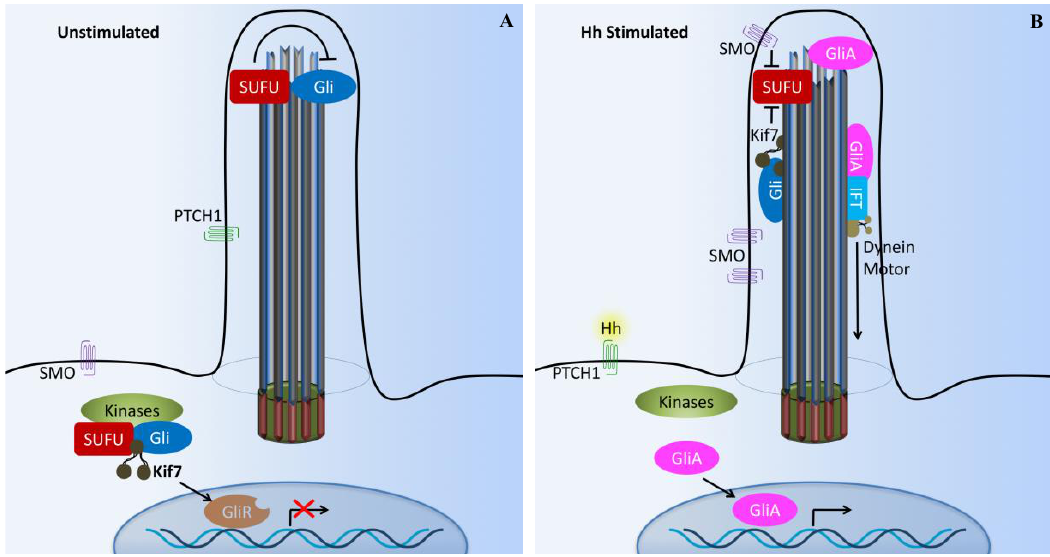
Figure 3. Cilia-dependent Hedgehog signaling. ( A ) The Hedgehog (Hh) pathway in vertebrates utilizes cilium as a signal transduction compartment. In the absence of the Hh ligand, the PTCH1 receptor localizes to the cilium and is thought to block the entry of SMO into cilia. The kinesin Kif7 (the COS2 homologue) localizes to the base of the cilium, where it may form a complex with Gli transcription factors and other pathway components. Kif7 at the cilium base prevents Gli proteins’ enrichment within the cilium and promotes processing of GliRs. ( B ) Upon Hh binding, SMO moves to the ciliary membrane and Kif7 translocates into the primary cilium, thereby promoting Gli accumulation at the ciliary tip. Kif7 and SMP in the cilia may also block the function of SUFU. Activated Gli (GliA) is transported out of the cilium by the dynein motor and intraflagellar transport particles (IFT). X and T symbols denote inhibition of gene transcription and protein function, respectively.